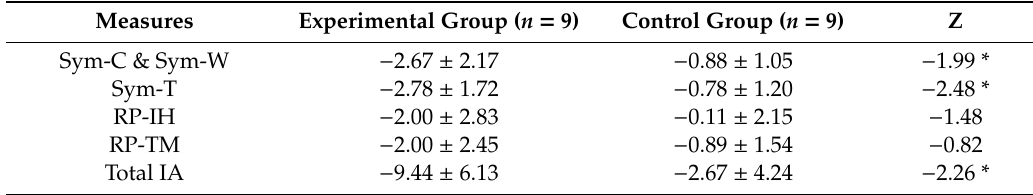
Table 2. Comparison between the Experimental and Control